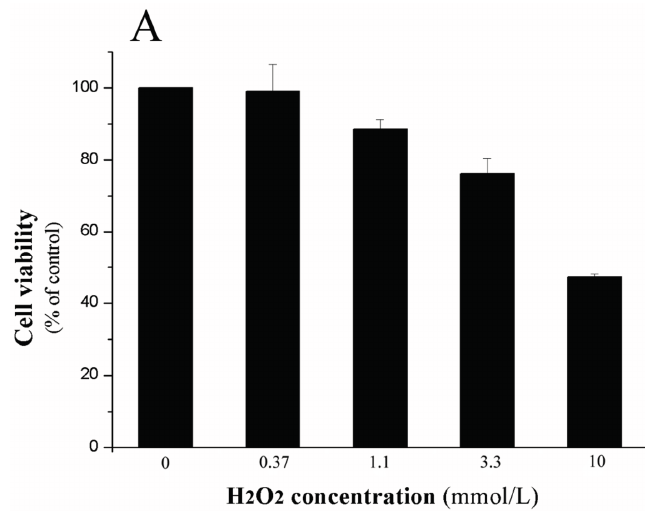
Figure 4. In vitro anti-oxidative effects of the isolated quinochalcone C -glycosides against H 2 O 2 -induced cytotoxicity in cultured H9c2 cells. ( A ) Various concentrations of H 2 O 2 (0, 0.37, 1.1, 3.3 and 10 mmol/L) were added onto cultured H9c2 cells, incubated for 1 h and determined with cell viability; ( B ) The isolated quinochalcone C -glycosides (60 μ g/mL) were pretreated with H9c2 cells for 24 h before the addition of H 2 O 2 (10 mmol/L) for cytotoxicity test as in ( A ). Vitamin C (1.1 mg/mL) served as a positive control (statistical significance is indicated as * p = 0.031 for hydroxysafflor yellow C vs. safflomin C; ** p = 0.005 for hydroxysafflor yellow C vs. saffloquinoside C; *** p = 0.001 for hydroxysafflor yellow C vs.